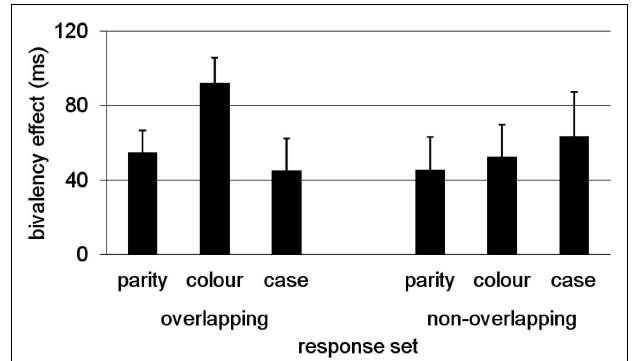
FIGURE 3 | Invariant bivalency effect across response-set conditions depicted as DT difference between univalent stimuli from the mixed block and the average of the pure blocks. Results adapted from Rey-Mermet and Meier (2012a) averaged across experiments.